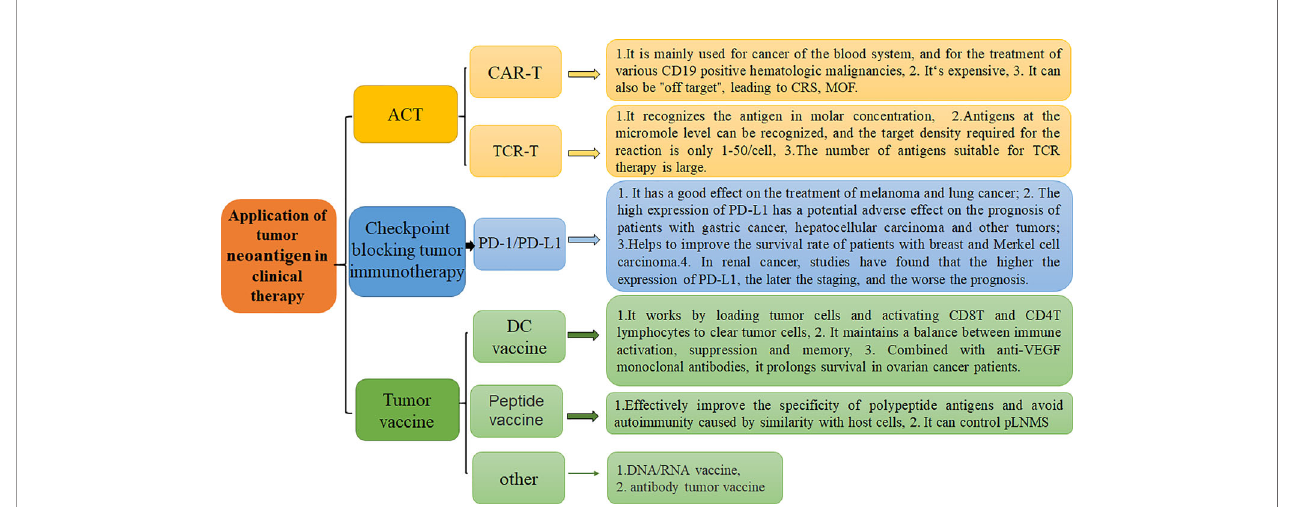
FIGURE 4 | Application of tumor neoantigen-based strategies in clinical therapy and their respective characteristics. There are three primary clinical treatment methods, including ACT, Checkpoint blocking tumor immunotherapy, and tumor